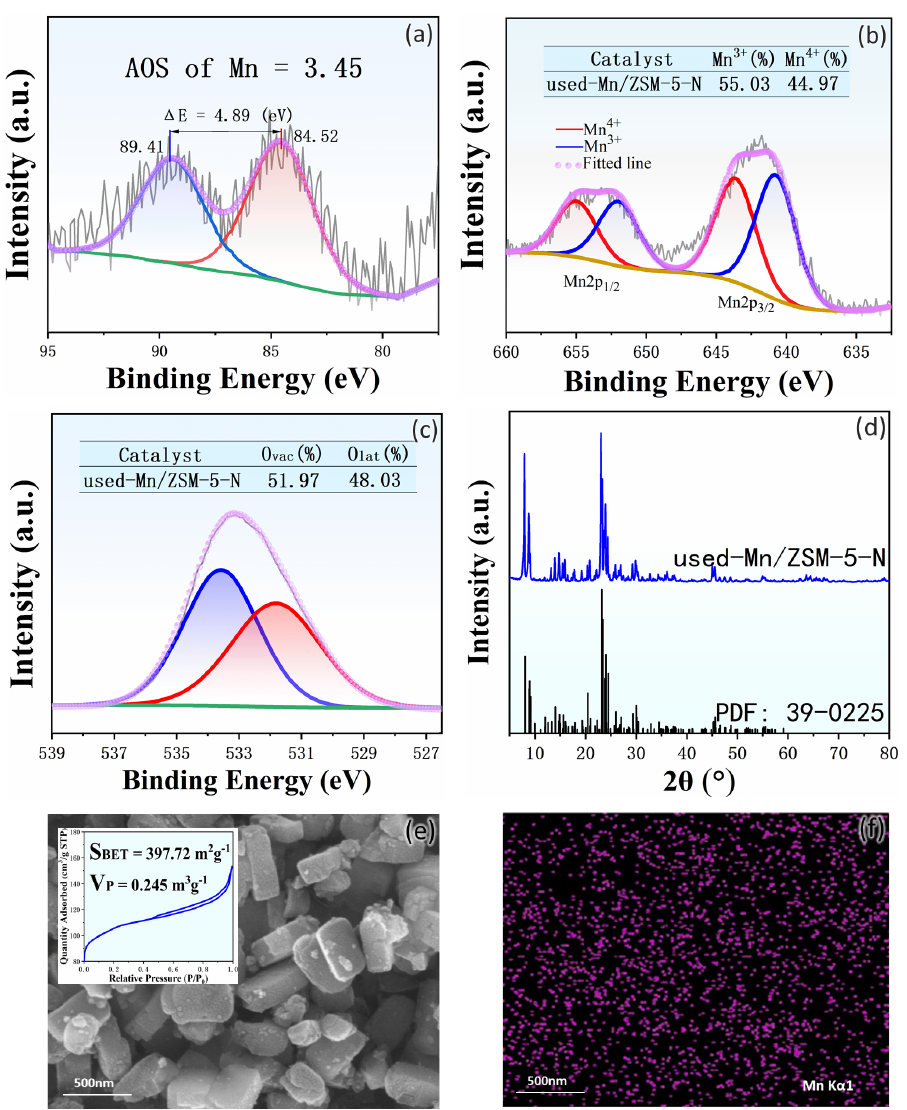
Figure 13. ( a ) Mn 3s, ( b ) Mn 2p, ( c ) O 1s photoemission features from XPS results of used Mn/ZSM ‐ 5 ‐ N, ( d ) XRD pattern, ( e ) SEM images and N 2 adsorption–desorption plot, ( f ) Mn EDS mapping of used ‐ Mn/ZSM ‐ 5 ‐ N.